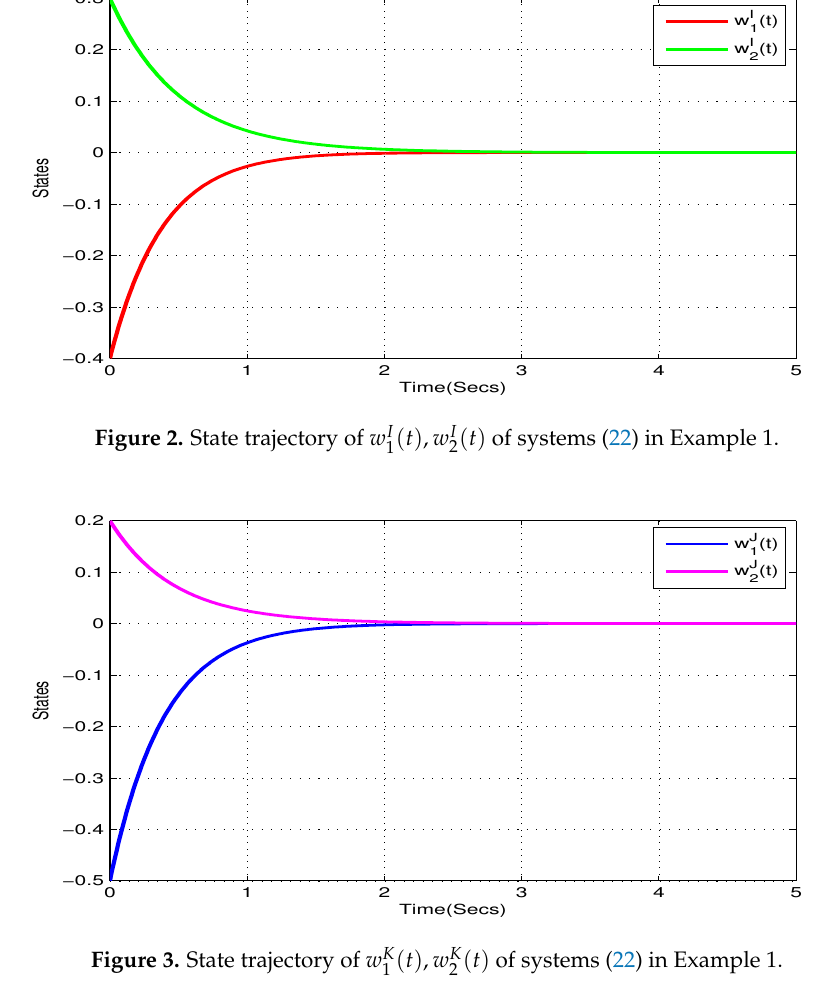
Figure 3. State trajectory of w K